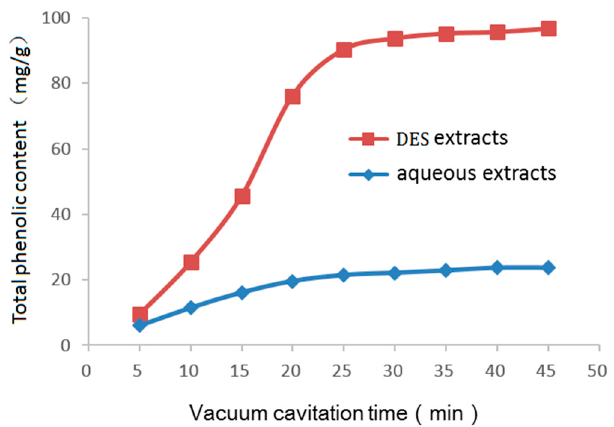
Figure 6. Effect of vacuum-cavitation time on the total phenolic content.